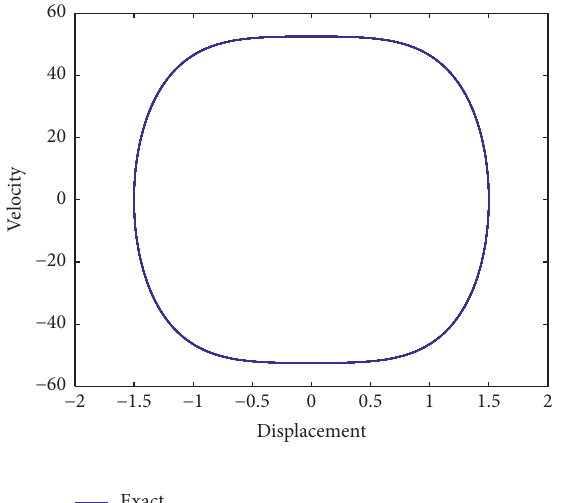
Figure 15: Phase portrait of the hardening spring calculated using � 0 . 8 ) when Δ t � T /20. CQ-2 x ( ρ ∞